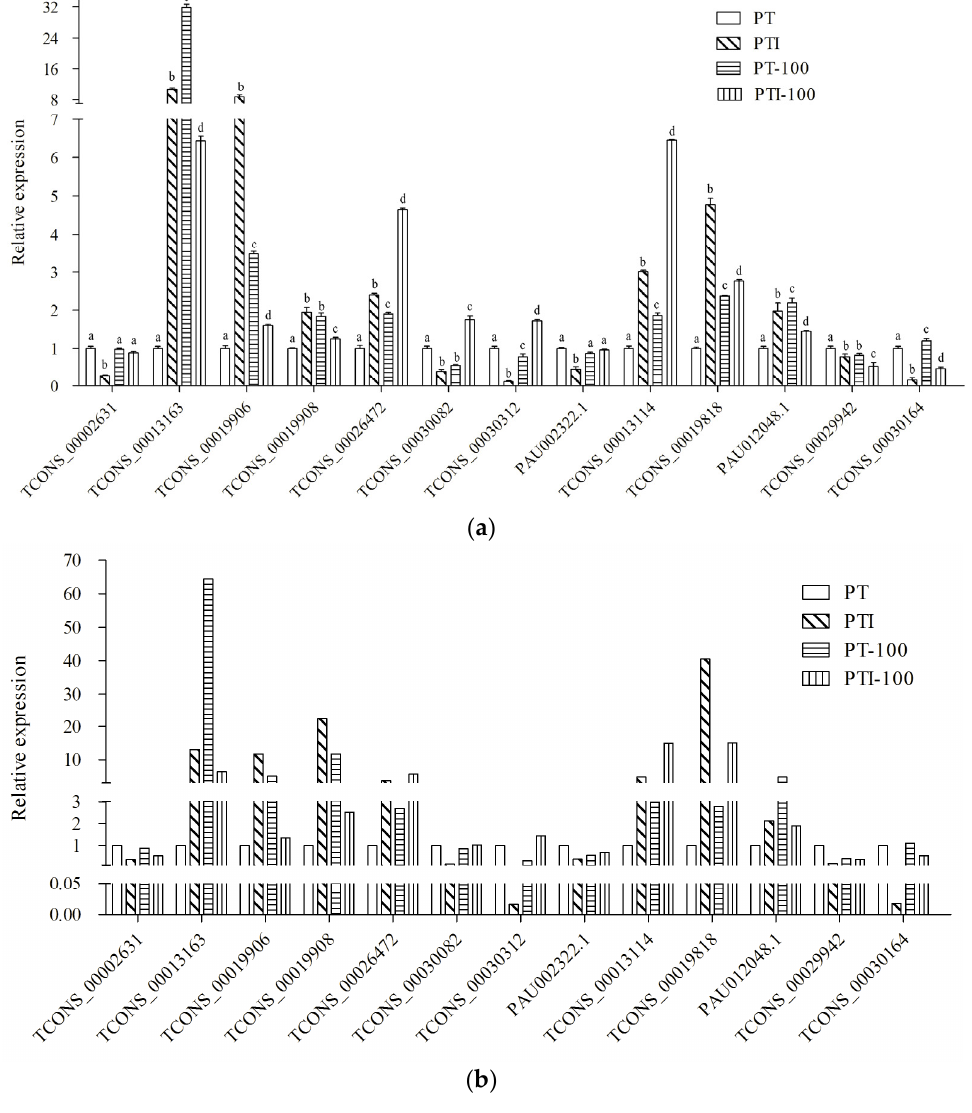
Figure 5. Expression pattern confirmation by qRT-PCR. ( a ) Changes in the relative expression levels as determined by qRT-PCR. Standard error of the mean for three technical replicates is represented by the error bars. Samples marked with various letters show a significant difference at p < 0.05; ( b ) Changes in the relative expression levels as determined by RNA-seq. The expression level of PT was set to 1.